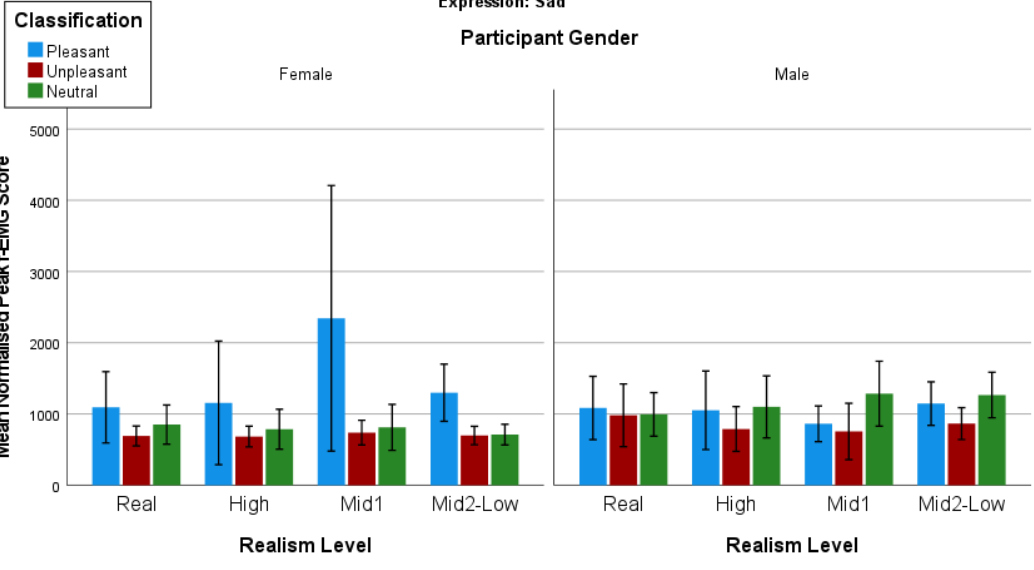
Figure 11. Mean valid responses by participant bio sex for avatars with sad expressions grouped by realism level.